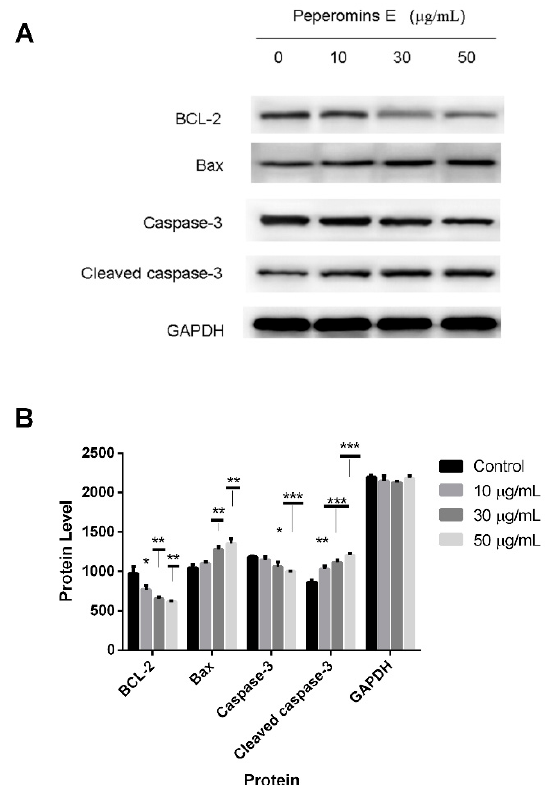
Figure 6. Effects of peperomin E on the protein levels of apoptosis related biomarkers in cells by western blotting. ( A ) The representative Western blot images showing the effects of peperomin E on the levels of Bax, Bcl-2, Caspase-3, cleaved-caspase-3 in PC-3 cells. GAPDH was used as the internal control (bottom panel). ( B ) Quantitation of significantly altered protein levels in PC-3 cell line by densitometry. Data are presented as means ± SD ( n = 3). * P < 0.05, ** P < 0.01, *** P < 0.001 versus Con.